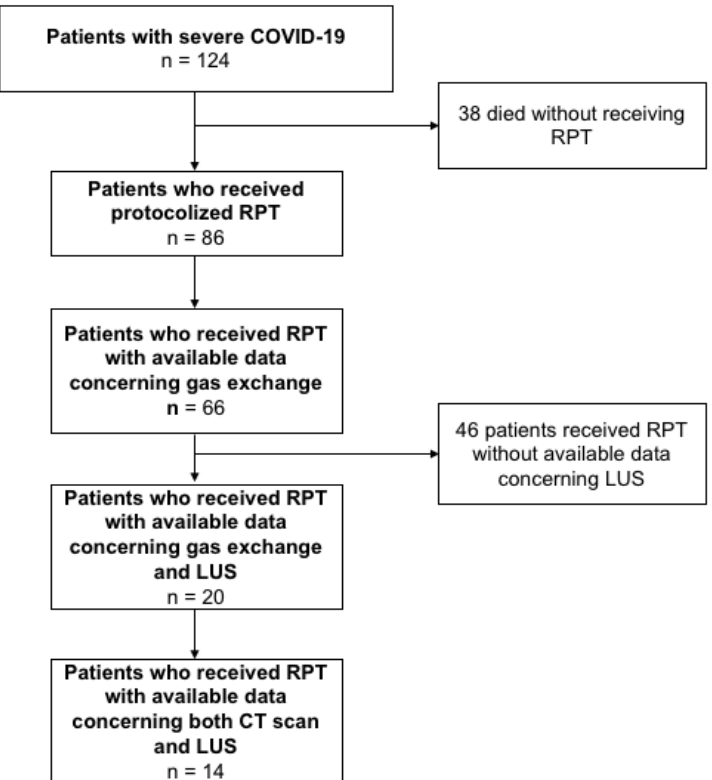
Figure 1. From 29th February 2020 to 30th June 2020, 124 patients confirmed positive for SARS-Cov-2 infection were admitted to the ICU. At ICU admission, all patients presented intubated and mechanically ventilated. Thirty-eight patients died before receiving respiratory physiotherapy (RPT), while eighty-six patients started RPT when deemed ready. Data concerning gas exchange during RPT were available for 66 patients, while data concerning lung ultrasound (LUS) imaging during RPT were available for 20 patients, of whom 14 presented a concomitant computed tomography (CT) scan performed within a few days from the RPT session.